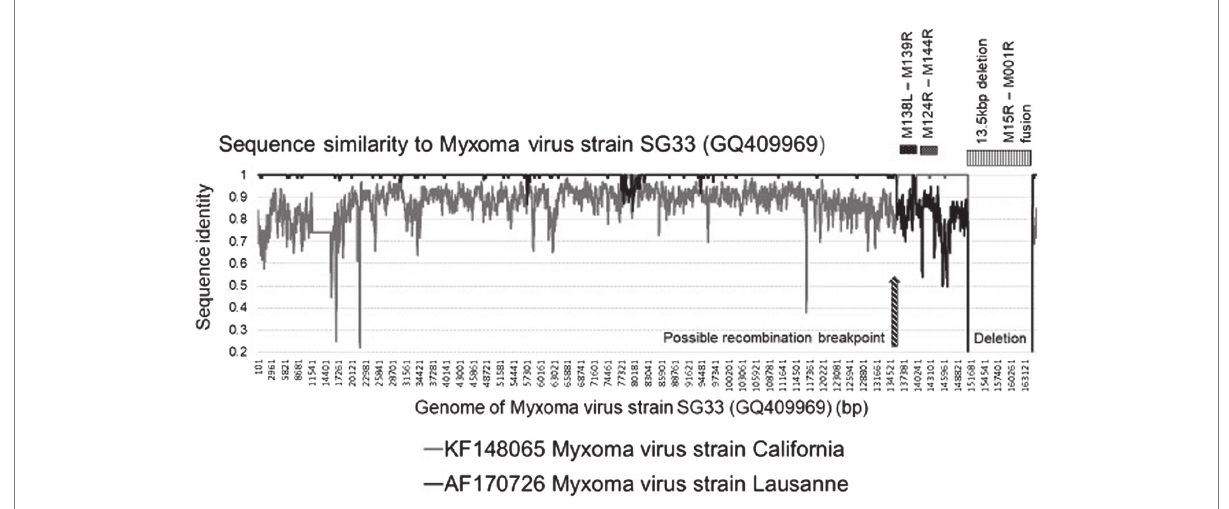
FIGURE 3 Graphical representation of the sequence identities of the Myxoma virus strains California (KF148065) and Lausanne (AF170726) against the sequence of strain SG33, using a 200 bp window, 20 bp step and Kimura-2 model in SimPlot. The 13 kb deletion in the SG33 genome is indicated as well as the predicted recombination